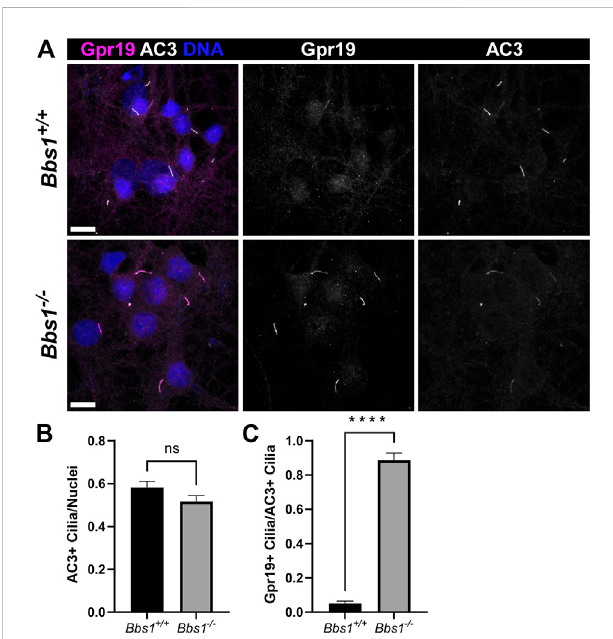
Gpr19 accumulates in cilia on Bbs1 − / − hippocampal neurons (A) Representative images of cultured hippocampal neurons from Bbs1 +/+ (upper row) and Bbs1 − / − (lower row) mice colabeled for Gpr19 (magenta) and AC3 (white). Note that Gpr19 ciliary localization is more pronounced in the Bbs1 − / − culture (middle panels). Nuclei are stained with DRAQ5 (blue). Scale bars represent 10 µm (B) Quanti fi cation of AC3-positive cilia relative to nuclei reveals a similar fraction between Bbs1 +/+ (470/836; n = 3 animals) and Bbs1 − / − (317/647; n = 3 animals) cultures (C) Quanti fi cation of Gpr19-positive cilia relative to AC3- positive cilia reveals a signi fi cant increase in Gpr19-positive cilia in Bbs1 − / − cultures (270/317; n = 3 animals), compared to Bbs1 +/+ cultures (20/470; n = 3 animals). Values are expressed as mean ± SEM. ns = not signi fi cantly different, **** p < 0.0001.